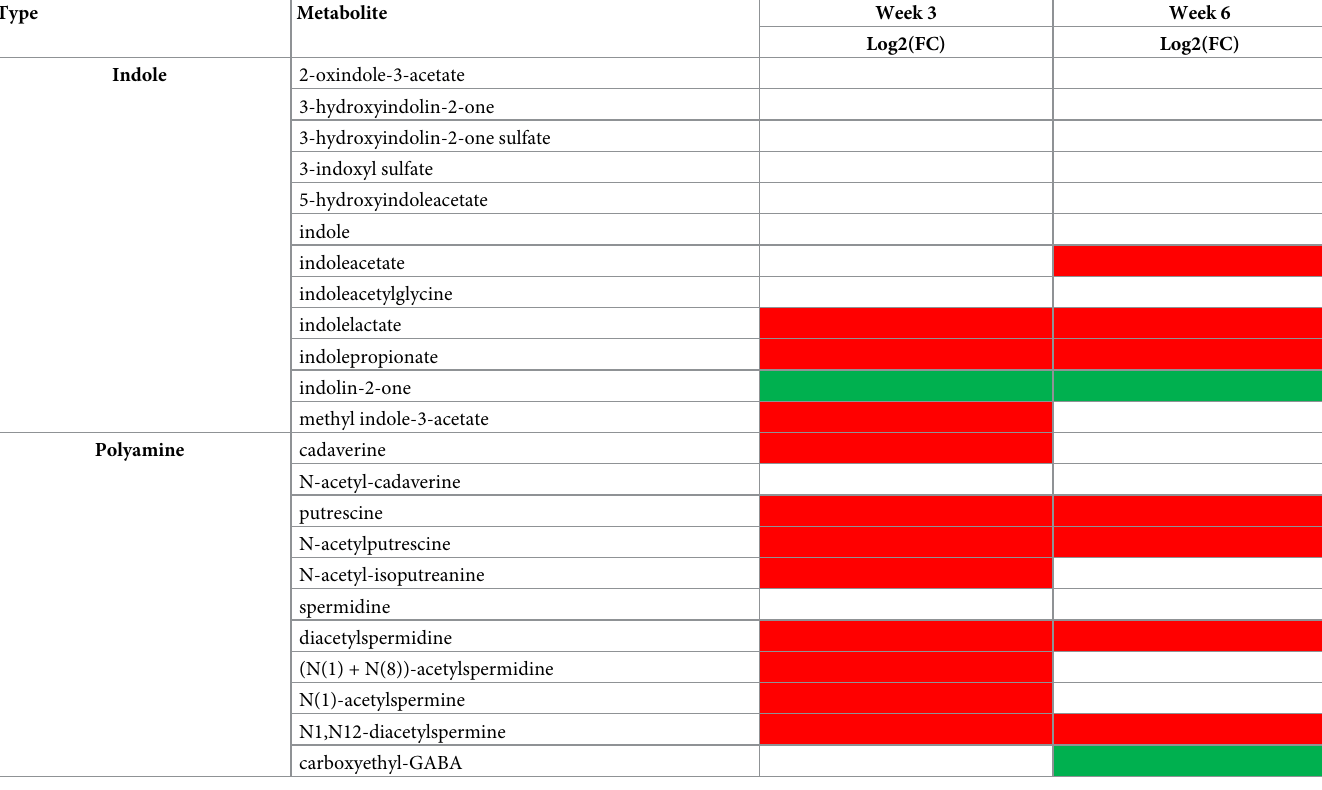
Table 6. Indoles and polyamines detected via metabolomic screening in fecal samples taken at weeks 3 and 6 from cats fed LRS or HRS food.